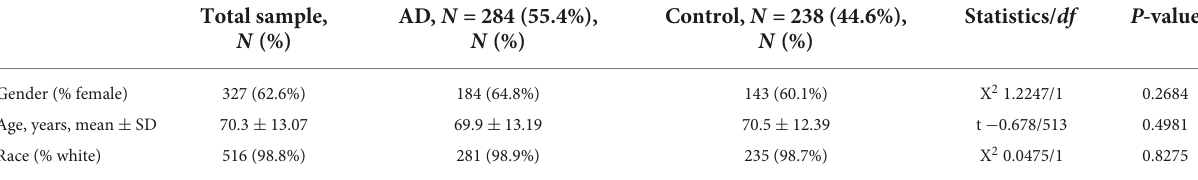
TABLE 3 Clinical characters of the merged AD training data